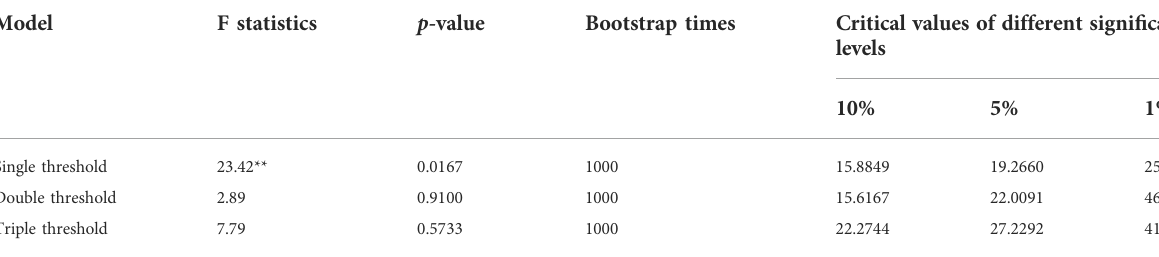
TABLE 3 Results of the threshold effect test.